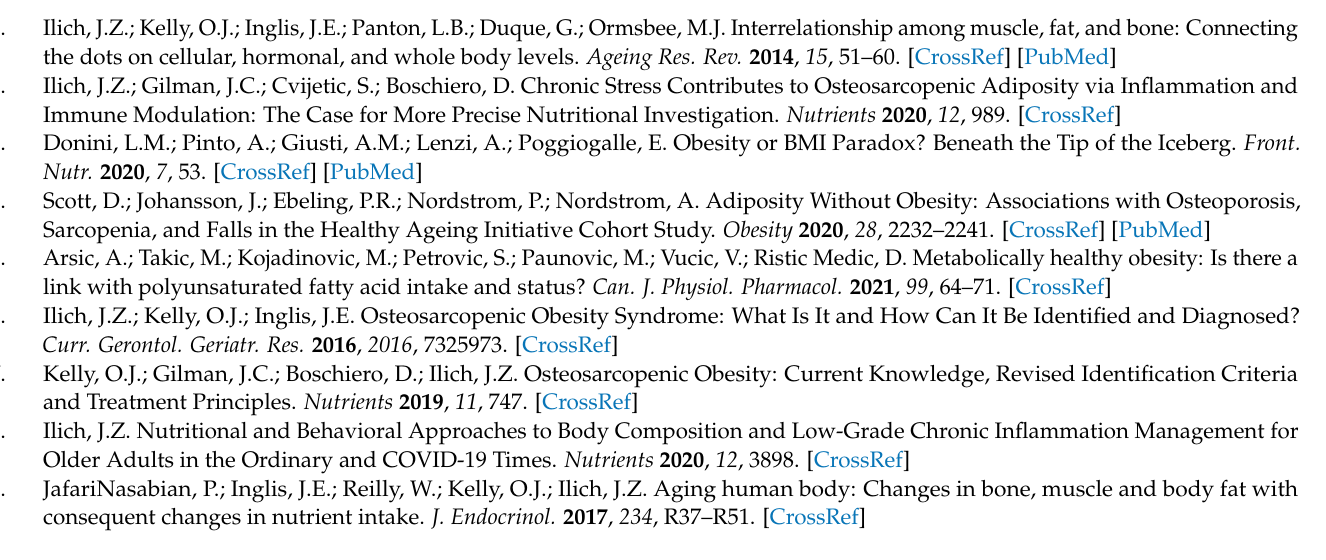
Table S3: Characteristics and results of studies with physical activity as independent variables related to osteosarcopenic adiposity/obesity